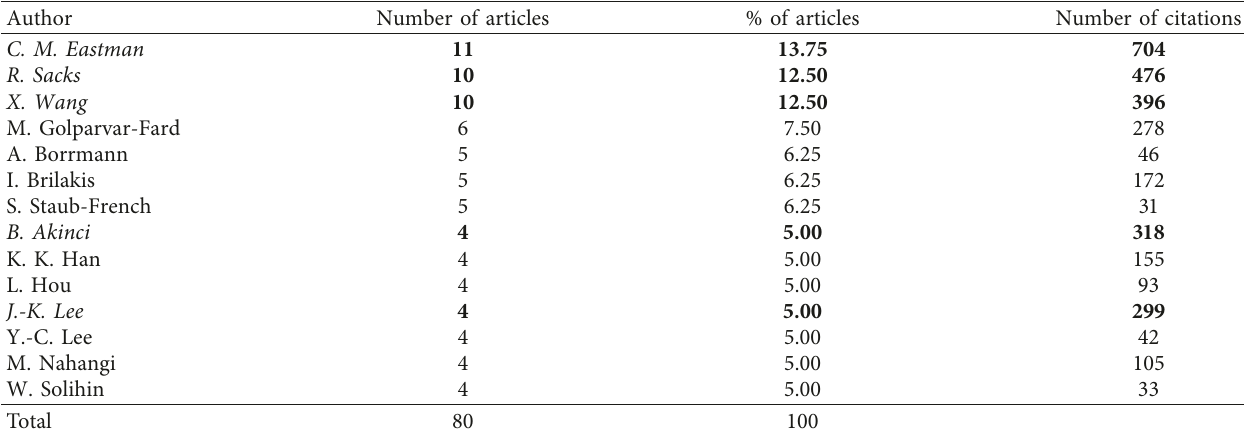
Table 2: The most active authors, whose number of articles focusing on BIM for structural engineering exceeds three.